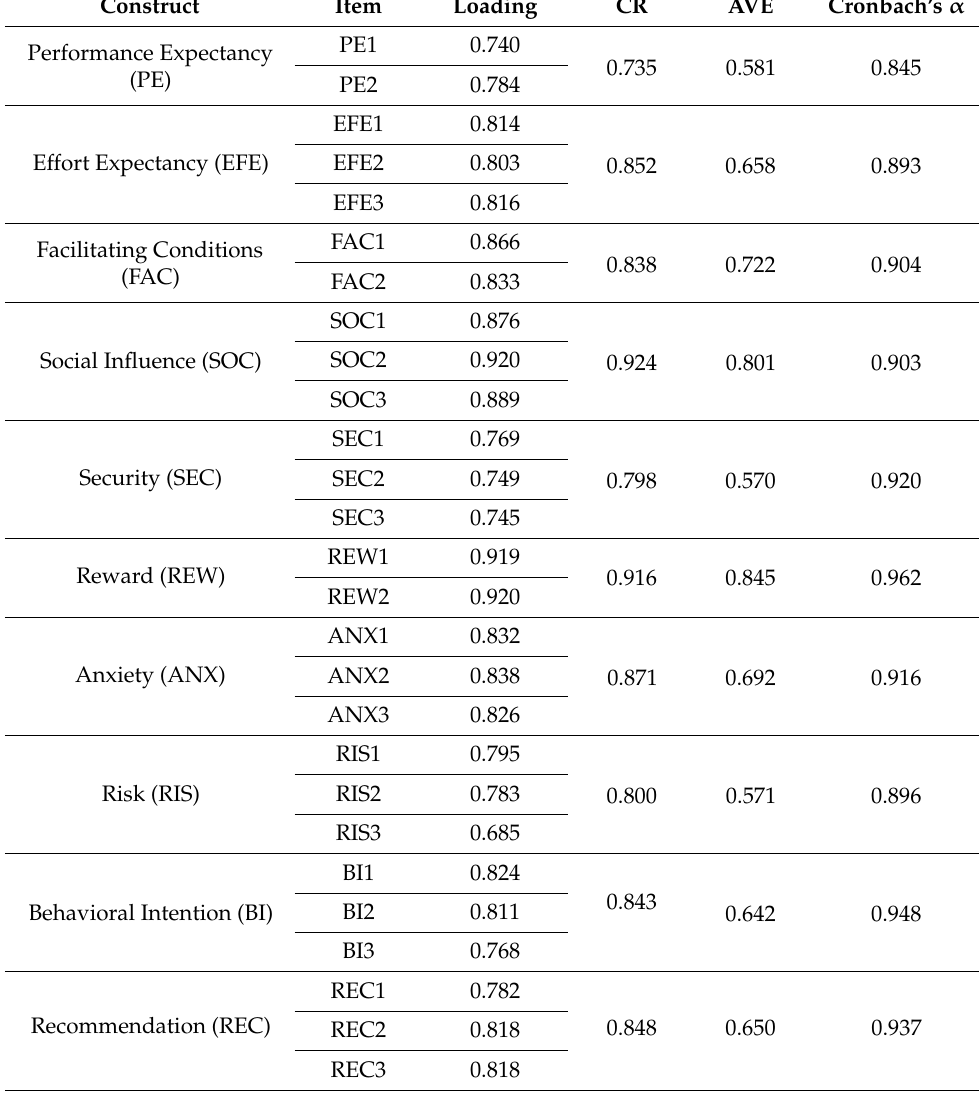
Table 3. Standardized factor loadings and individual item